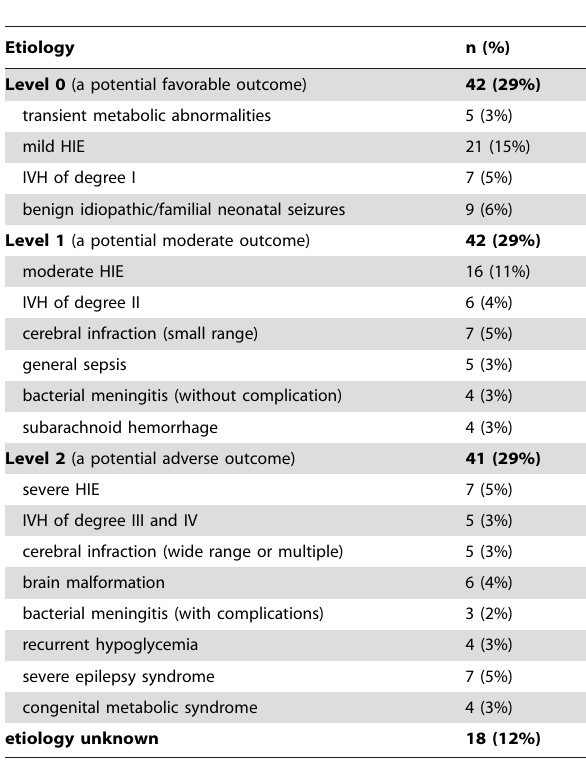
Table 2. aEEG and etiology scores obtained at neonatal period associated with outcome findings at the age of one